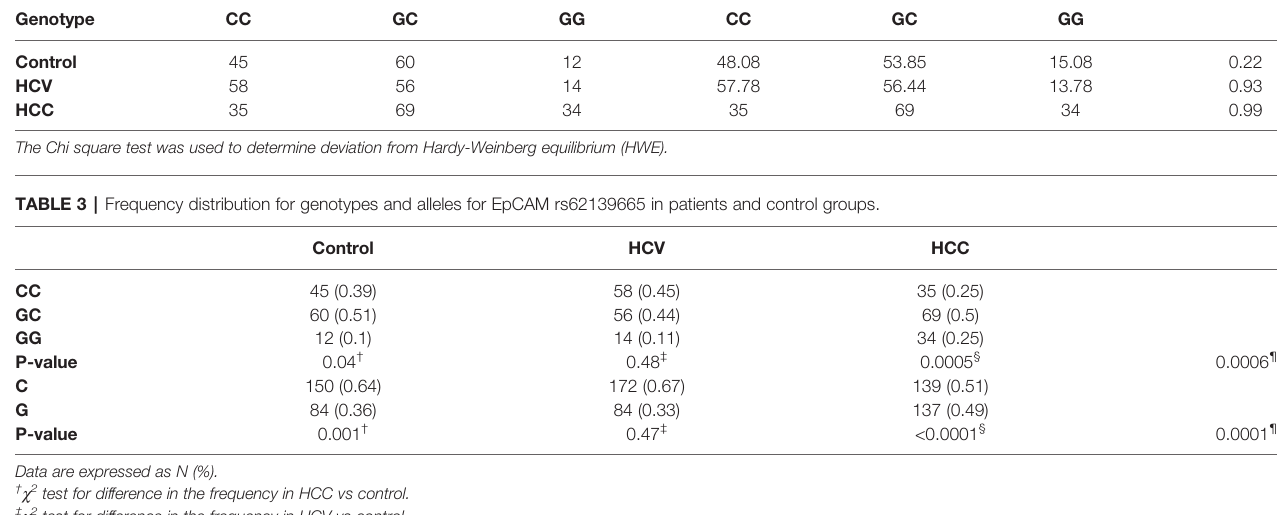
TABLE 2 | Hardy Weinberg equilibrium for EpCAM -935 C/G (rs62139665). Group